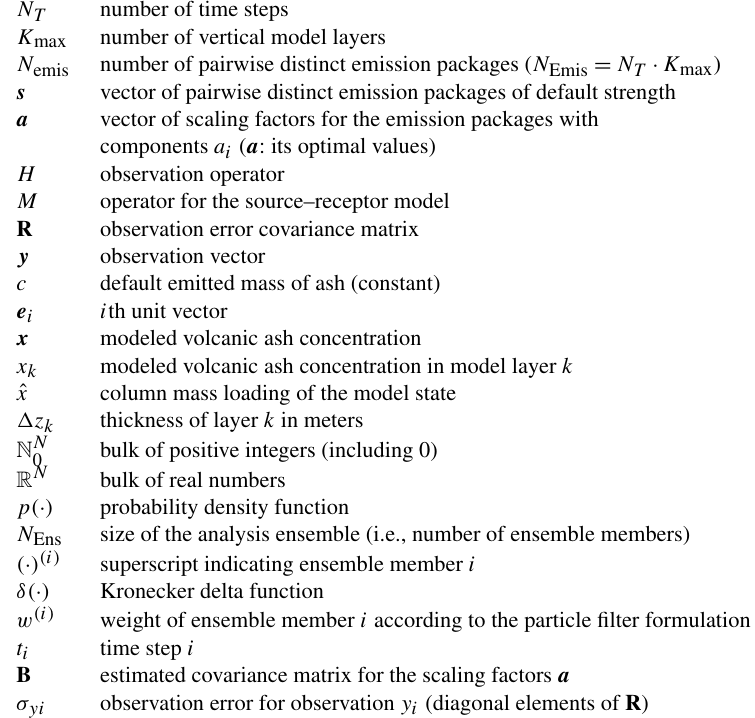
Table A1. Nomenclature for variables used in this